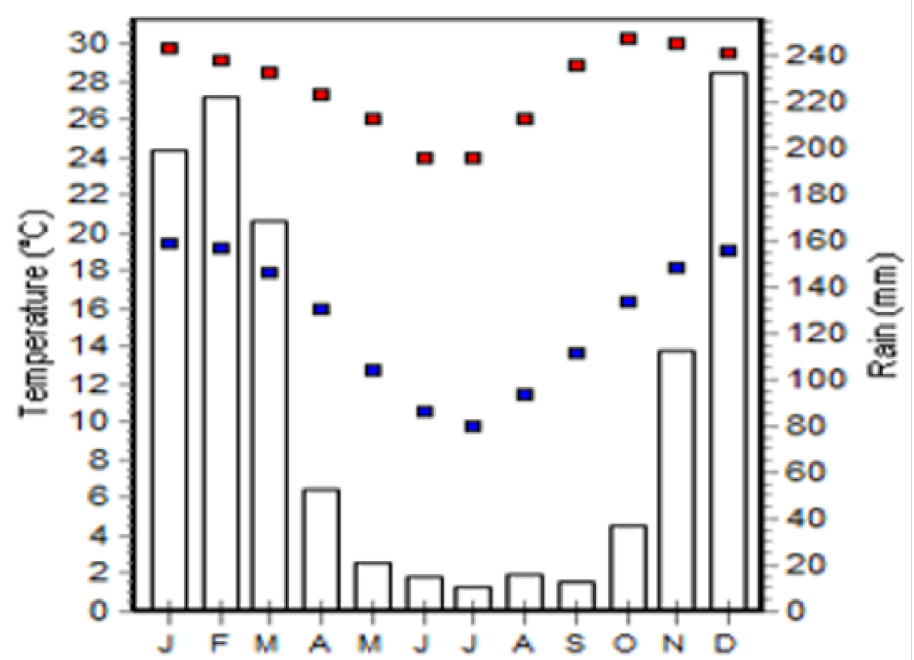
Figure 4. Long term minimum and maximum temperature and, precipitation for Sussundenga 1970/2000. Source: Worldclim (European Environmental